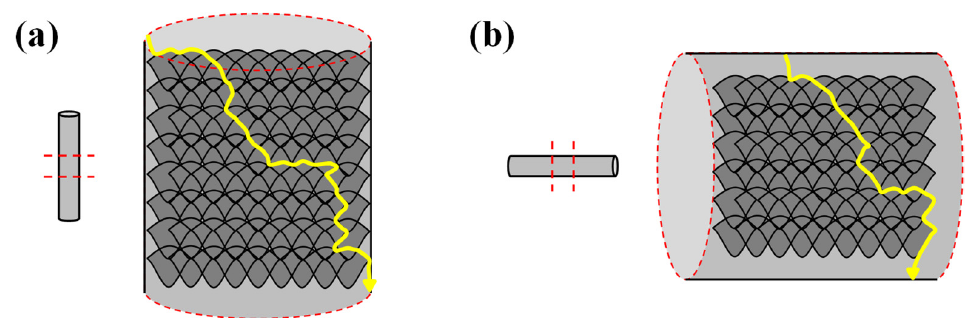
Figure 11. Schematic illustration of the difference of creep crack propagation path according to the building direction: ( a ) stacked vertical as-built; ( b ) stacked horizontal LPBF as-built.